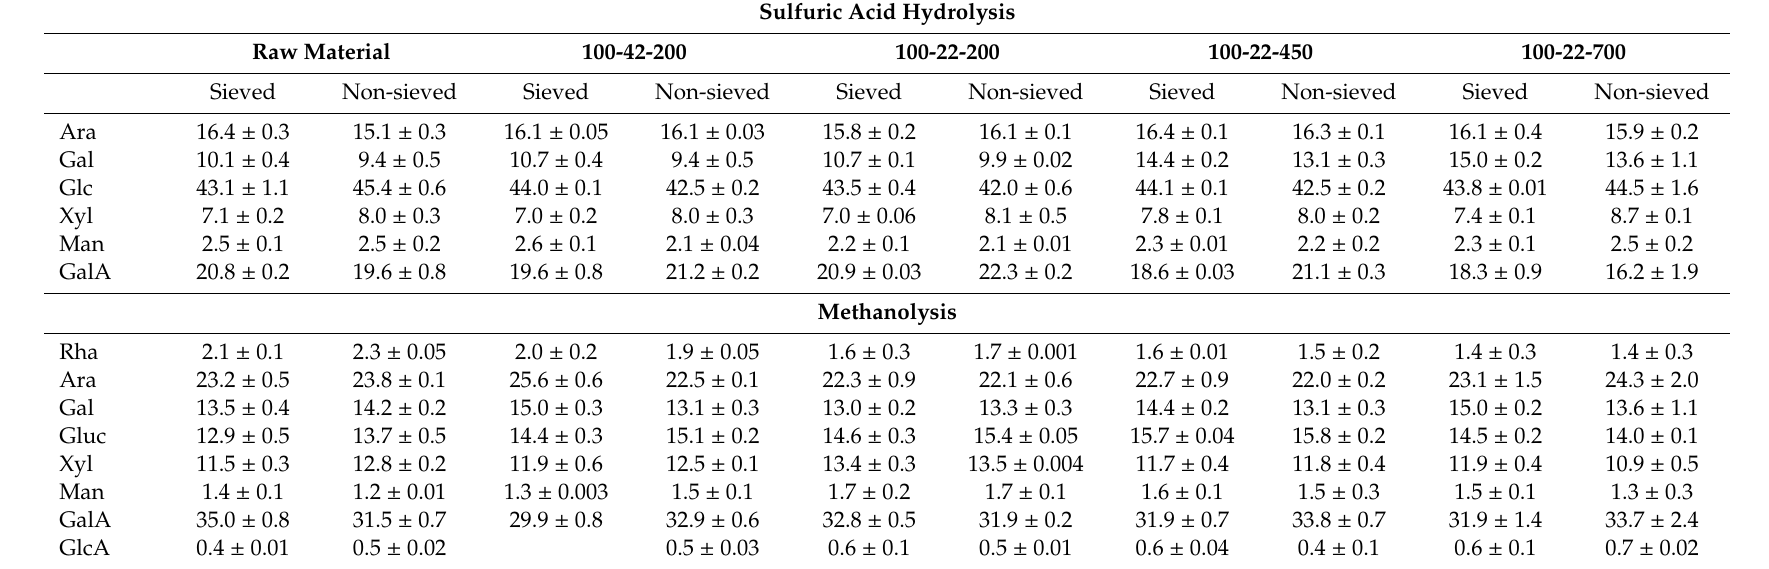
Table A1. Monosaccharide composition (mol%) of the polysaccharides of the sieved and non-sieved fraction of apple pomace (raw and extruded) after sulfuric